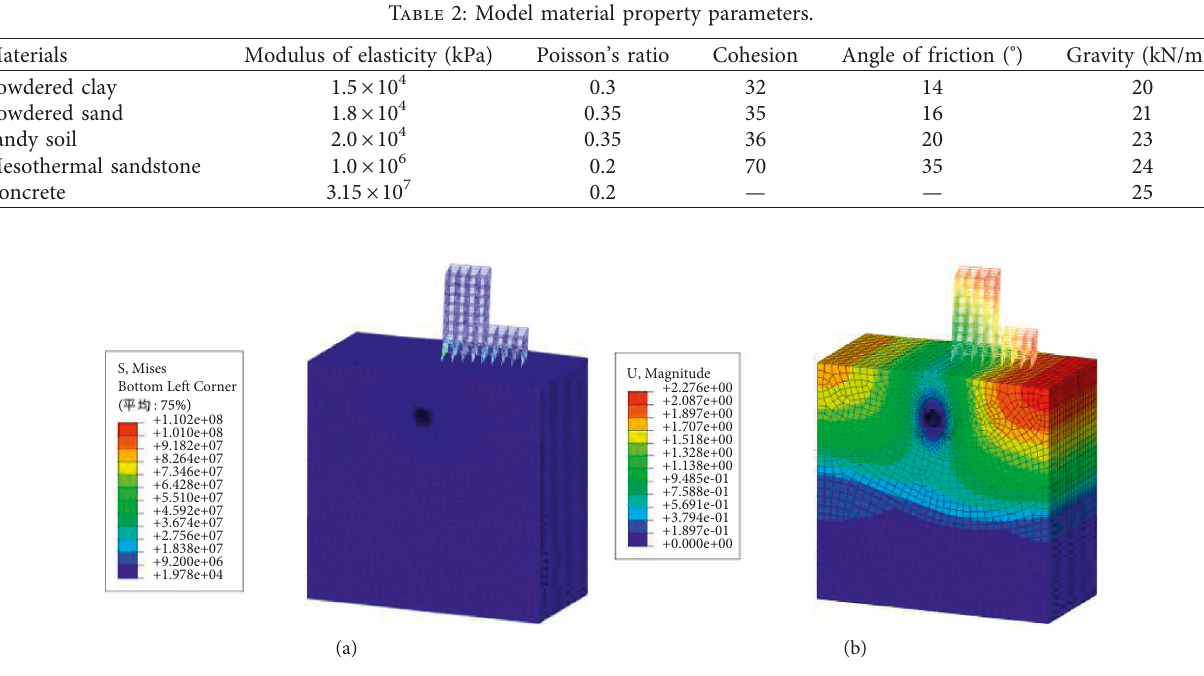
Figure 8: First static analysis results of the tunneling model. (a) Stress cloud diagram. (b) Displacement cloud map.